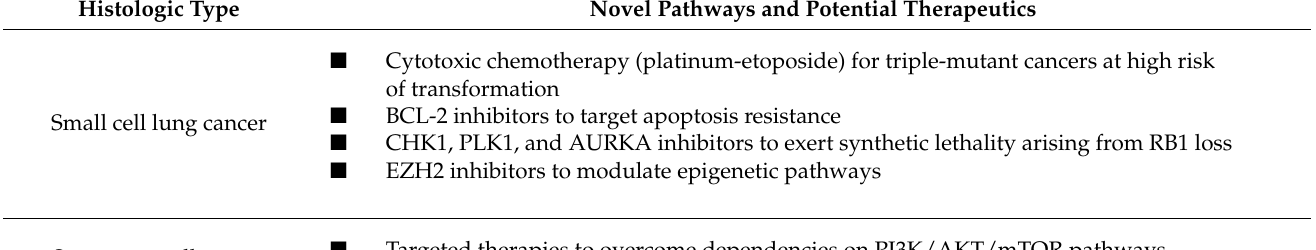
Table 1. Novel pathways and potential therapies for histologically transformed EGFR-mutant lung cancers. Histologic Type Novel Pathways and Potential